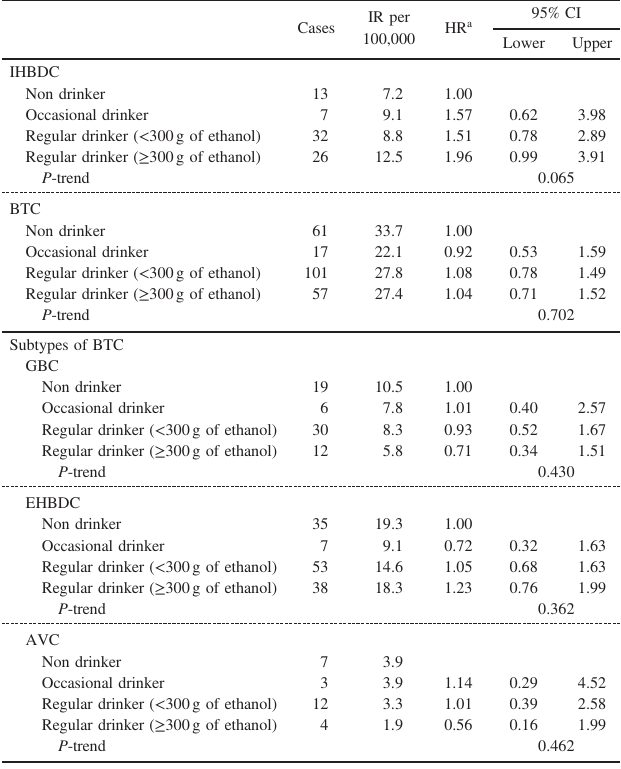
Table 2. HRs and 95% CIs of the incidence of BTC and IHBDC according to smoking in men Cases